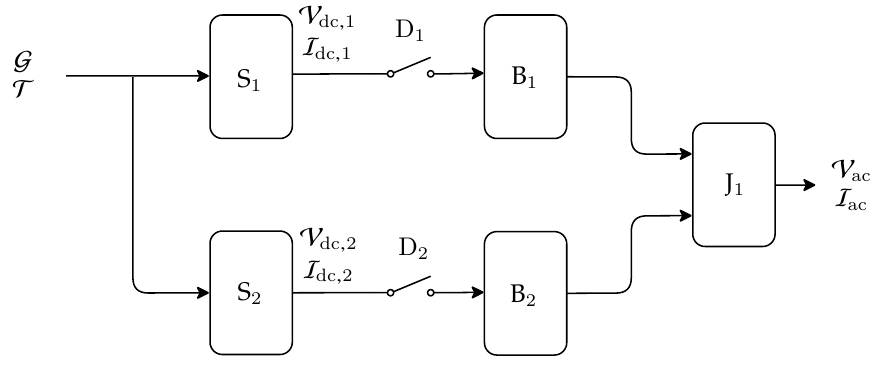
Figure 7: The proposed method consists in transmitting a frame using ⌈ α n cha ⌉ channel uses for the fi rst trans- mission attempt, with 0 < α ≤ 1 . In the event of a decoding error, incremental redundancy is transmitted 1 − α n cha ⌋ channel uses. making use of the rest of the available ⌊ ( )